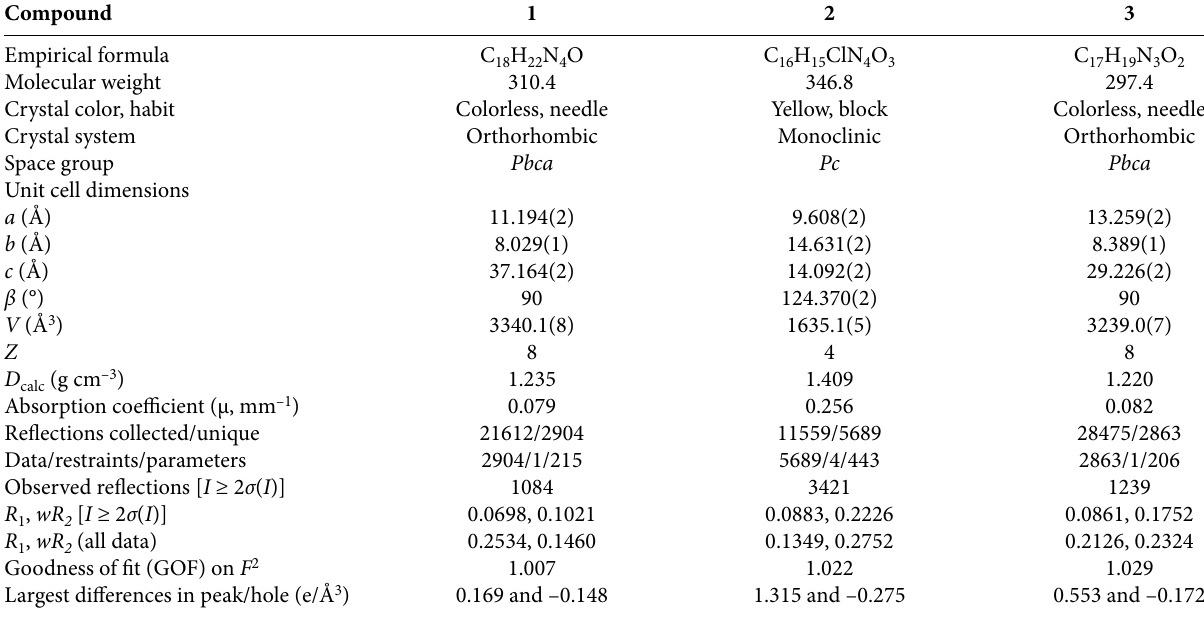
Table 1. Crystallographic data and refinement parameters for the